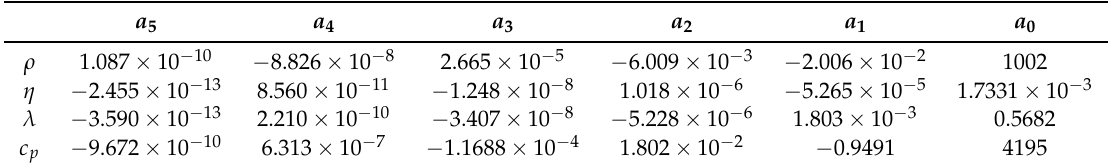
Table 2. Coefficients for properties of